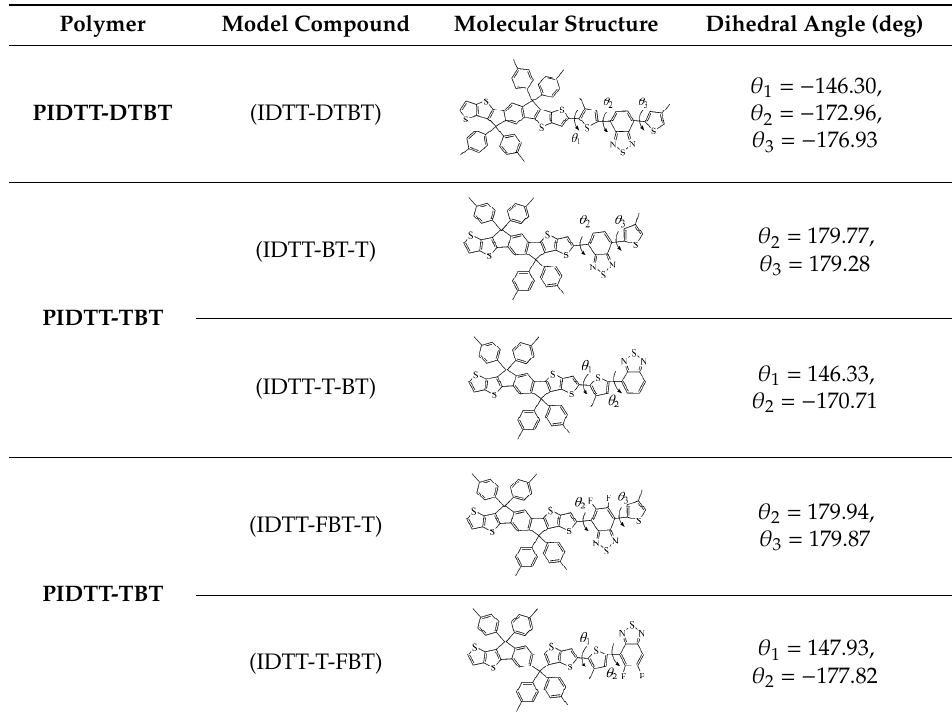
Figure 6. The optimized geometries and molecular orbital surfaces of the HOMO and LUMO for the unimer model compound of the polymers PIDTT-DTBT, PIDTT-TBT, and PIDTT-TFBT. Table 2. Dihedral angles for the unimer models of PIDTT-DTBT, PIDTT-TBT, and PIDTT-TFBT obtained at from DFT at the B3LYP/6-31G* level.